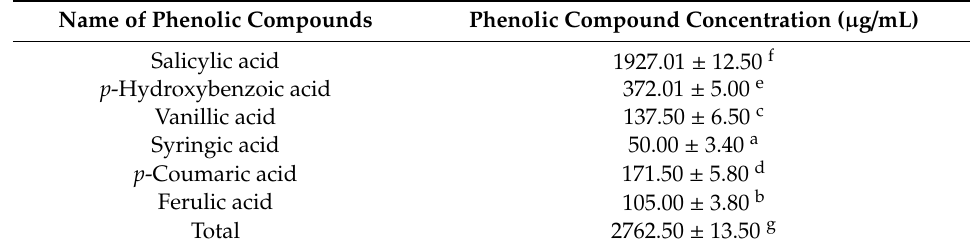
Table 2. Phenolic compounds in the alfalfa leaf extracts.